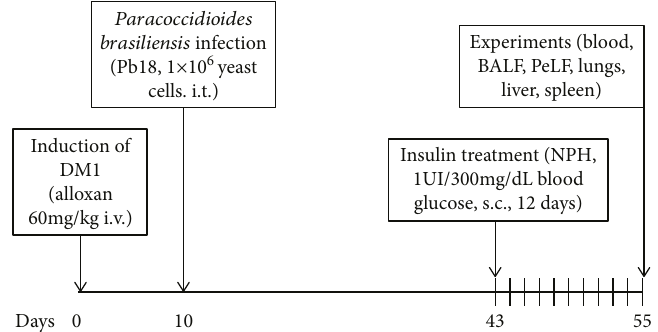
Figure 1: Paracoccidioides brasiliensis infection in the diabetes mellitus experimental